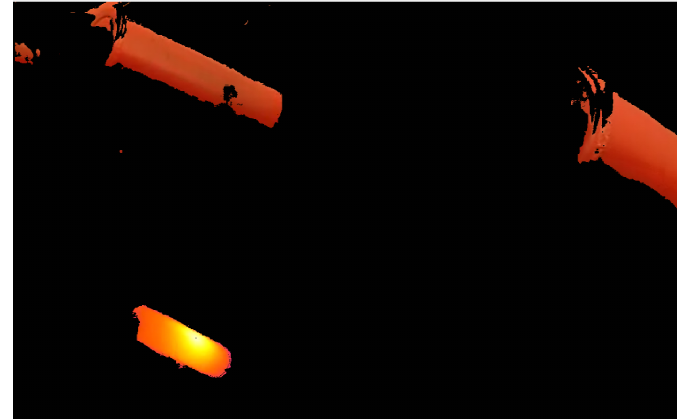
Figure 25. Result of infrared thermography image and RGB image fusion for one of idler with significantly higher